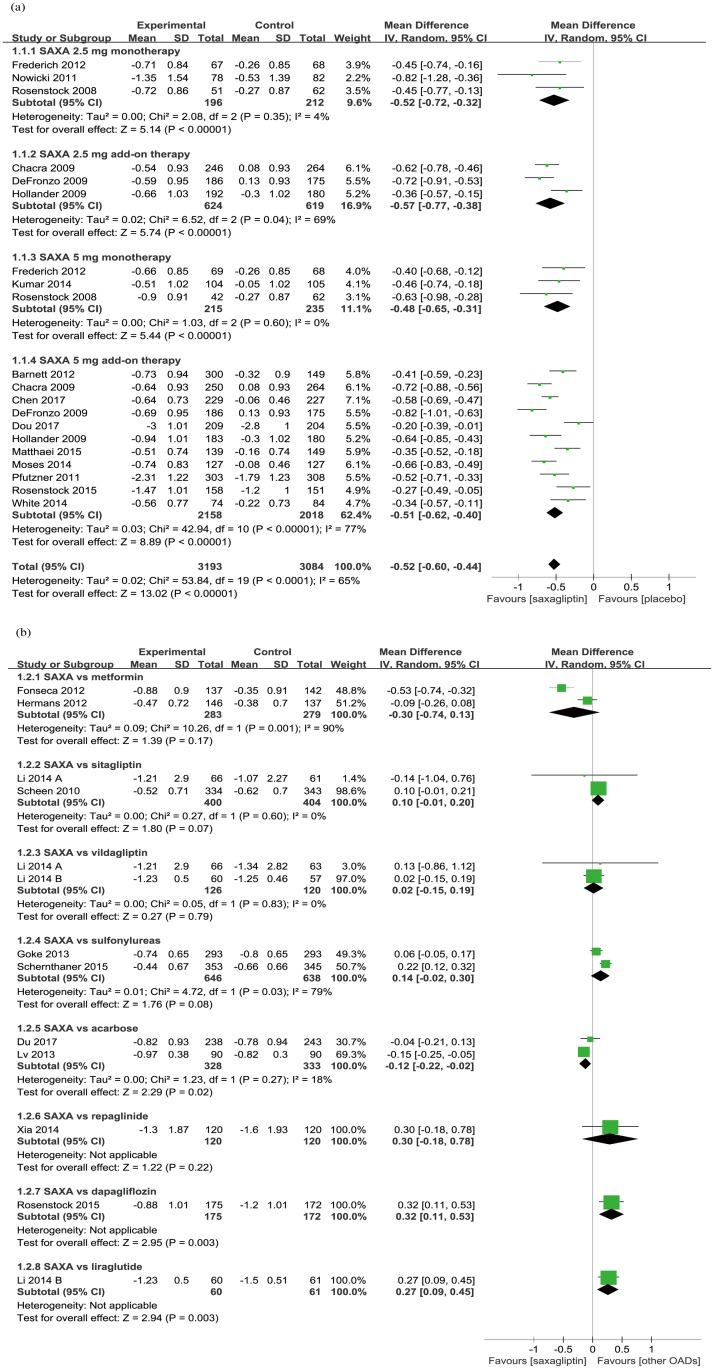
Mean change of HbA1c from baseline (a. saxagliptin vs placebo; b. saxagliptin vs active comparators).